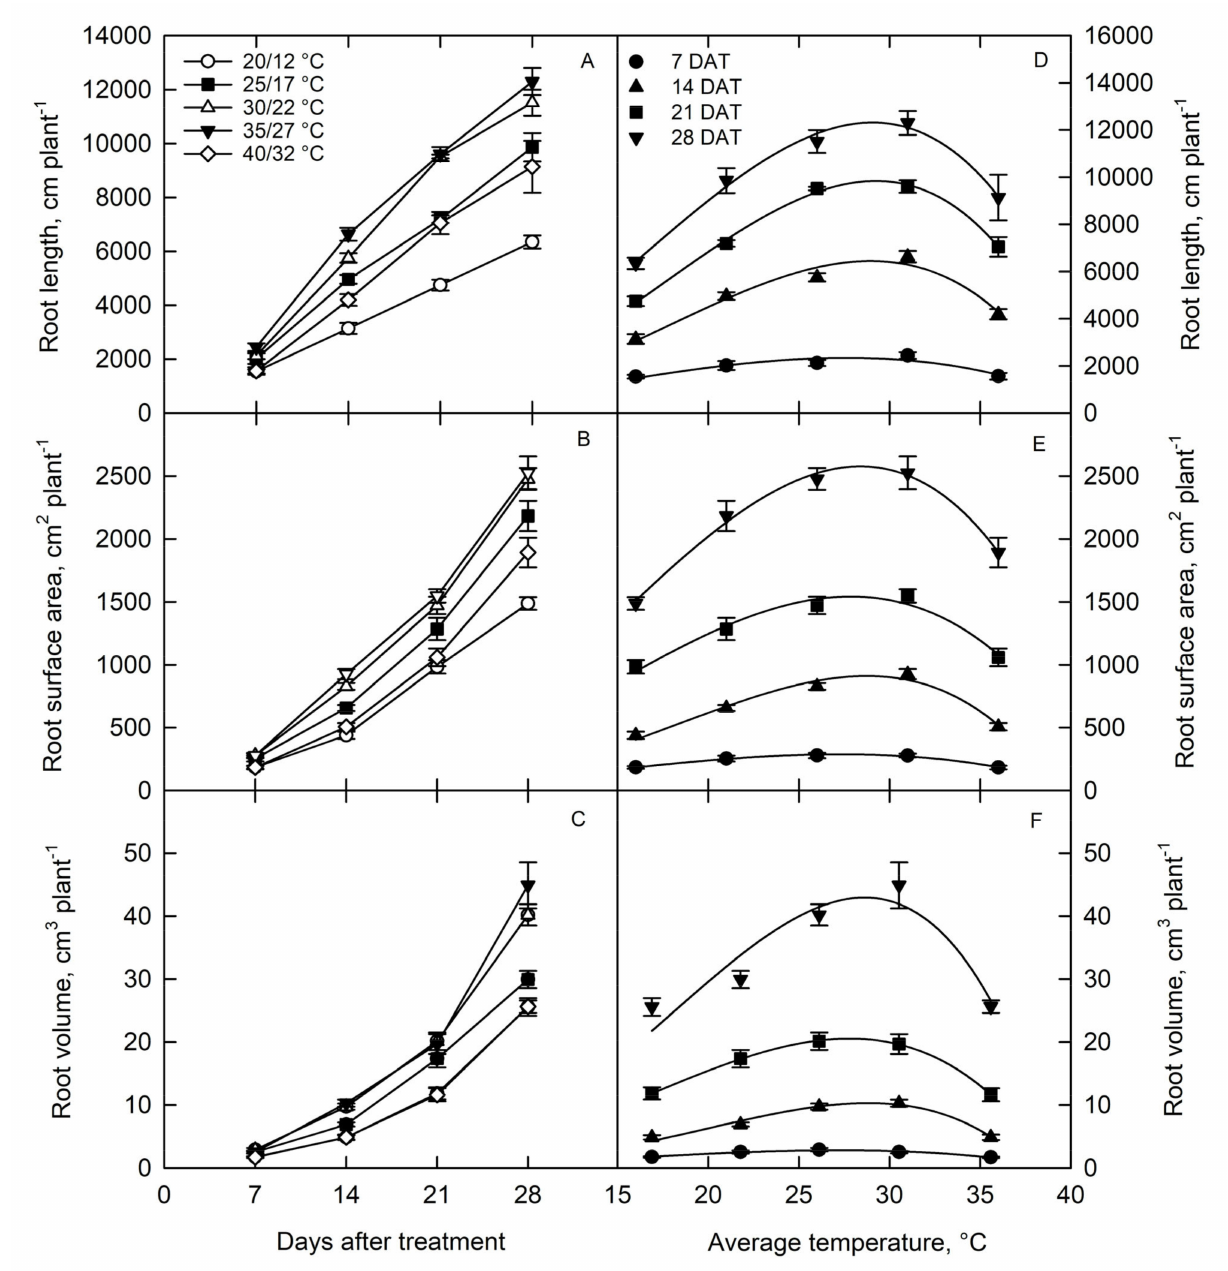
Figure 4. Temporal trends of corn ( A ) total root length, ( B ) root surface area, and ( C ) root volume under five temperature treatments over days after treatment and estimated mean growth rates from the weekly measurements as average function temperature for ( D ) total root length, ( E ) root surface area, and ( F ) root volume. A modified beta function model best described the biomass accumulation rates of various root growth parameters as a function of temperature. All values are the mean ± standard error of six replications at each harvest under each